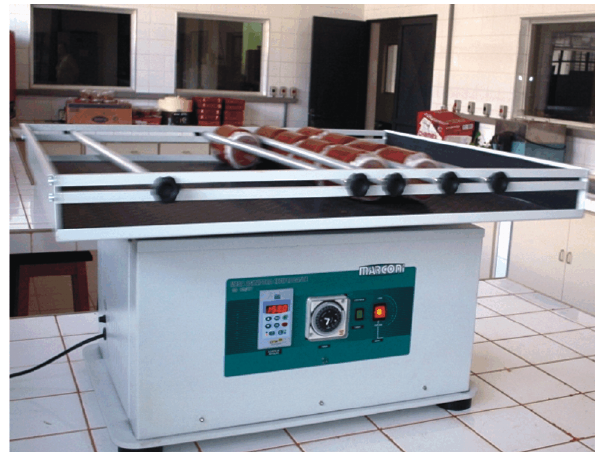
Figure 1. A view of the reciprocal shaker (RSh) as used for the mechanical dispersion of the soil samples using common glass